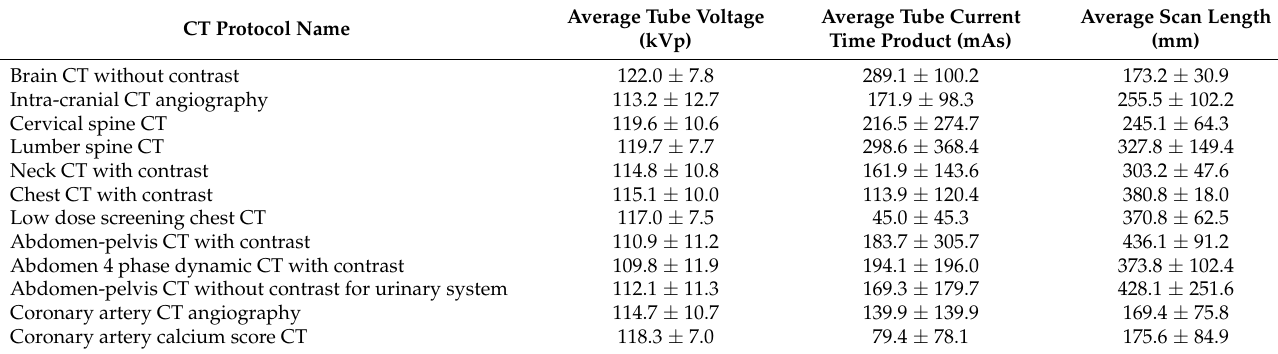
Table 5. The scan parameter for the 12 adult CT